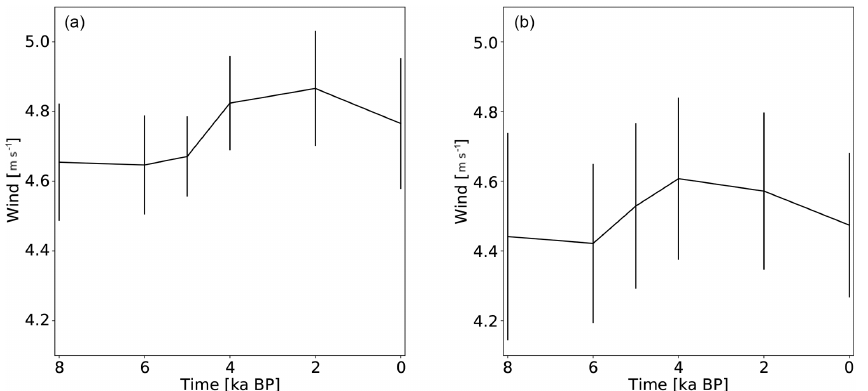
Figure 12. Simulated 10m wind strength averaged over the western Sahara (15 ◦ W–2 ◦ E, 18–29 ◦ N) for early spring (FMA, a ) and summer (JAS, b